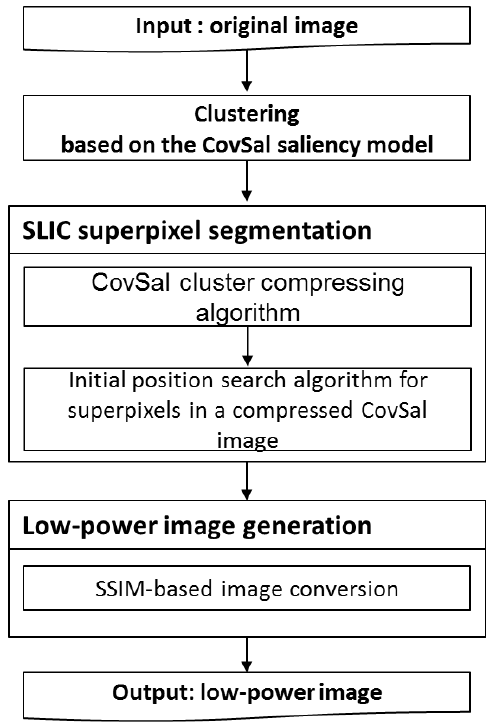
Figure 5. Overall flow of the proposed method.